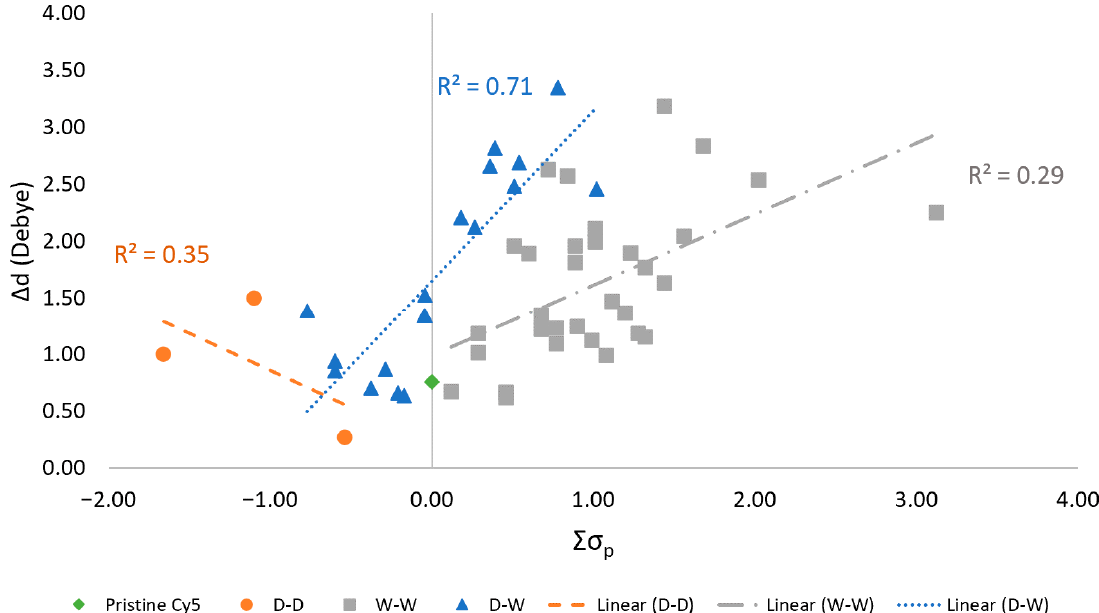
Figure 7. Static dipole difference magnitudes ( ∆ d ) found using the M06-2X functional plotted against the sum of the Hammett constants of the substituents attached to Cy5 dyes. Linear fits of the separate sets of data are shown along with corresponding R 2 values.